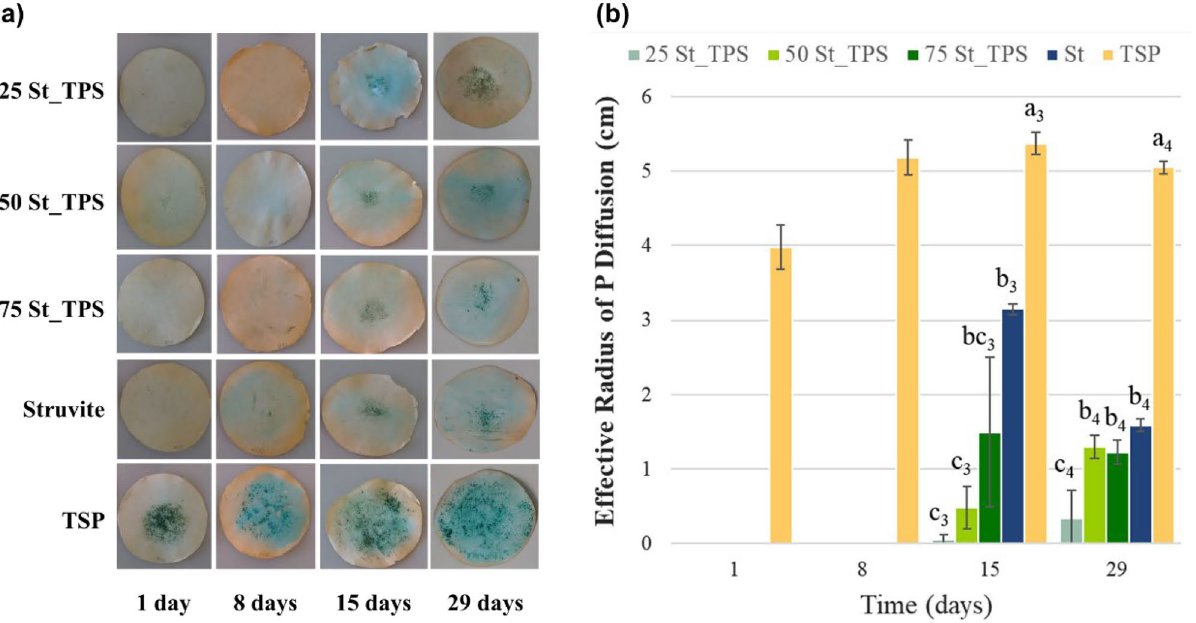
Figure 4. ( a ) P diffusion zone in sand substrate visualized at 1, 8, 15, and 29 days after fertilizer application of St, TSP, and St-TPS composites. ( b ) Effective radius of P diffusion zone (cm) over the incubation time. Bars show mean values ± standard deviations (n = 3). Indexes a, b, and c represent the statistical differences between treatments ( p < 0.05) for each time group (represented by index